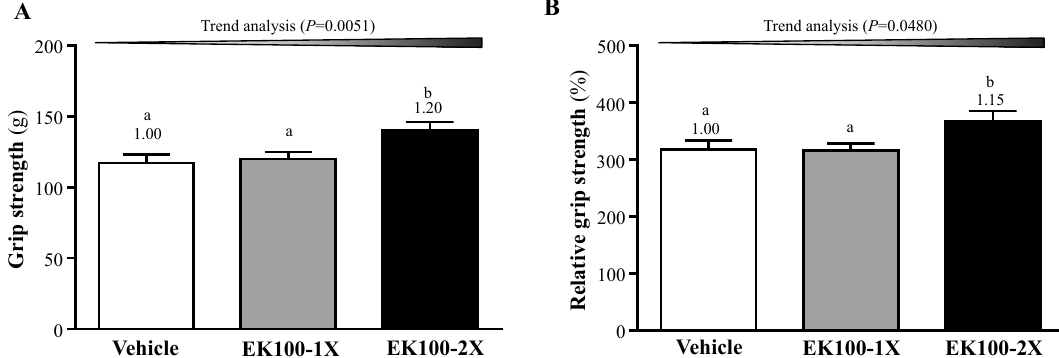
Figure 1. The effect of Ergosta-7,9(11),22-trien-3 β -ol (EK100) supplementation on ( A ) absolute forelimb grip strength and (B) relative forelimb grip strength (%) to body weight ( B ). Male ICR mice were supplemented with vehicle or 10 and 20 mg/kg EK100 (1X and 2X) for six weeks before undergoing a grip strength test 1 h after the final administered dose. Data is expressed as mean ± SEM for n = 8 mice in each group. One-way analysis of variance (ANOVA) was used for the analysis and different letters (a, b) indicate significant difference at P < 0.05.